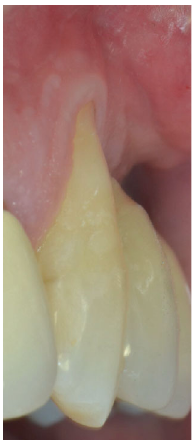
Figure 1: Left maxillary canine presenting a RT2 gingival defect. Figure 3: A minimum amount of keratinized tissue apical to the recession is still present.